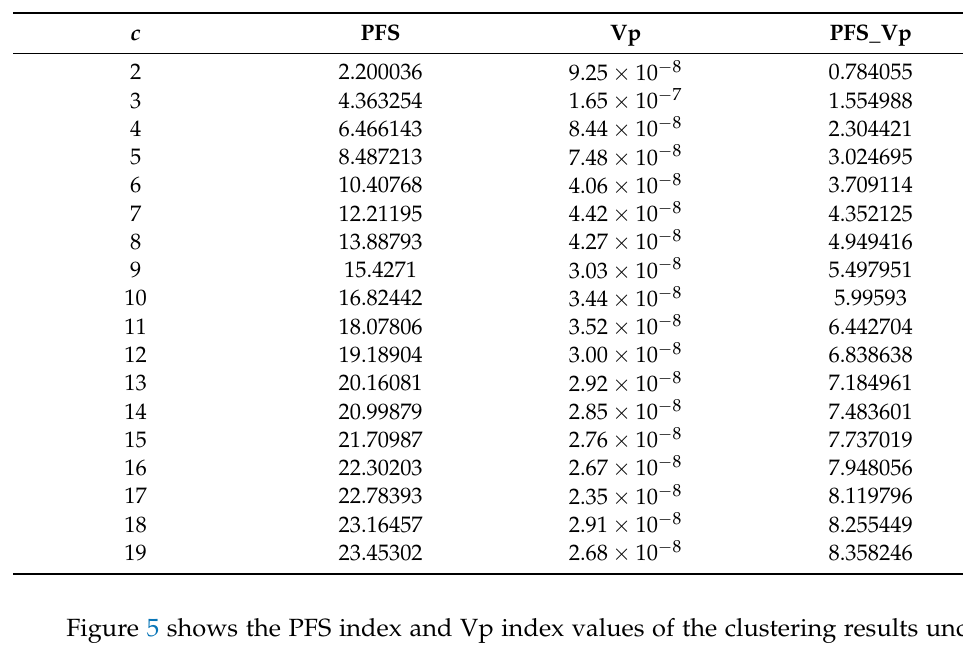
Table 2. When m = 1.1, the values of PFS, Vp, PFS_Vp under different c values.